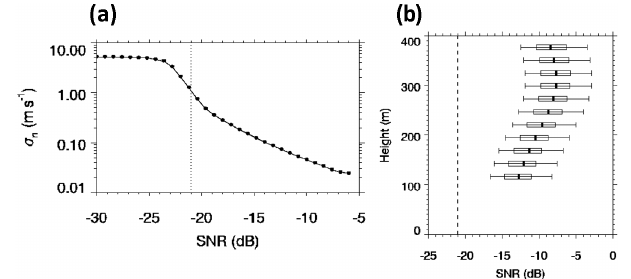
Figure 3. (a) The standard deviation of instrumental measurement precision, σ n , as a function of SNR, and (b) box and whisker plot of the SNR profile indicating the 10th, 25th, 50th, 75th and 90th percentiles. Both plots use data spanning the period from 6 March through 16 April